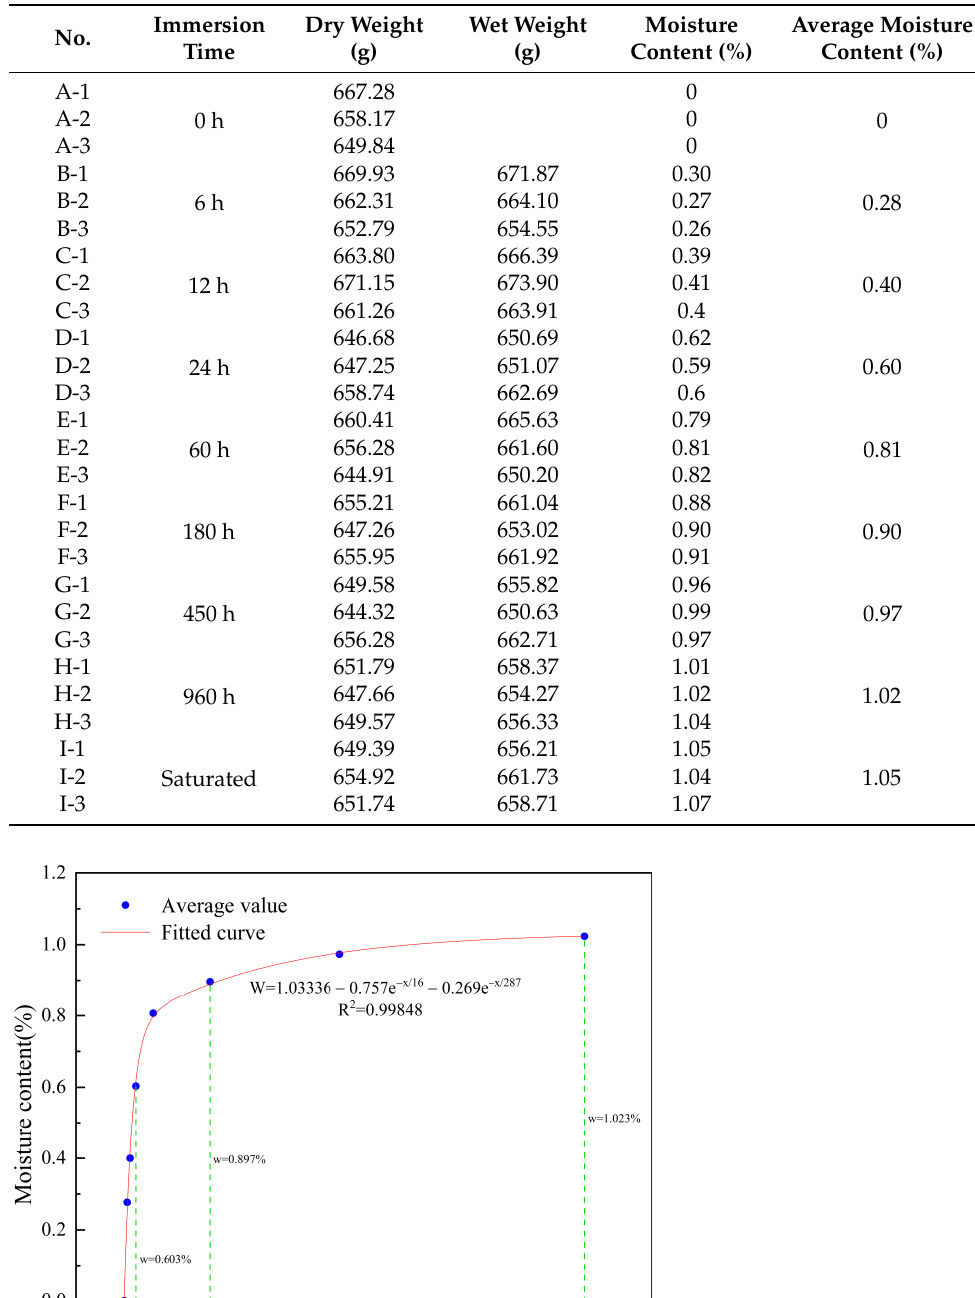
Table 2. Results of water absorption test.